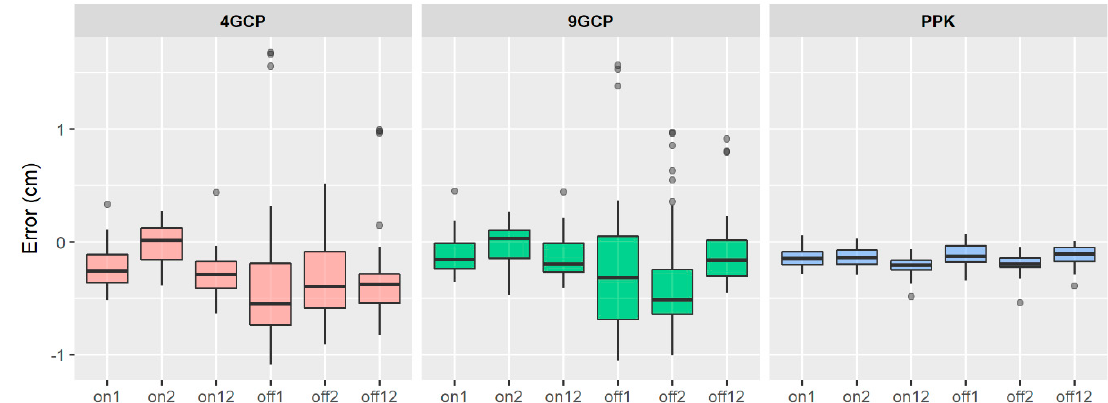
Figure 6. Boxplots represent vertical errors separated by georeferencing method and divided by the seasons and flight patterns (horizontal line represents median, the lower part of hinge represents the 25th percentile and upper part represent 75th percentile, whiskers represent 1.5 × IQR (interquality range) in both directions) acquired on point clouds.